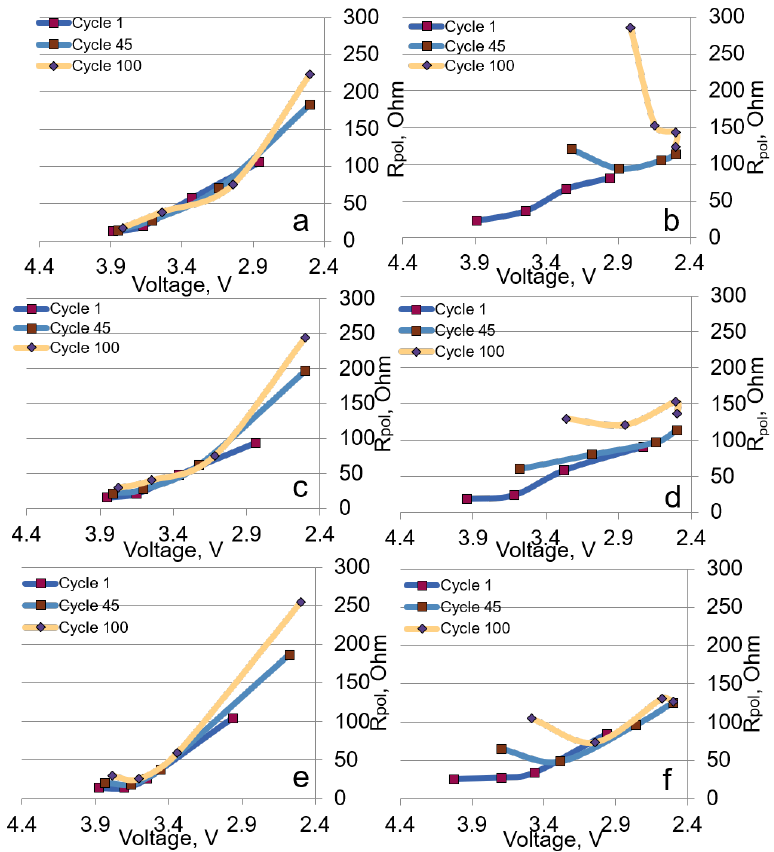
Figure 10. Polarization resistance values on discharge during cycling in the ranges of 2.5 – 4.3 V (( a ) LMR50, ( c ) LMR35, ( e ) LMR20) and 2.5 – 4.7 V (( b ) LMR50, ( d ) LMR35, ( f )